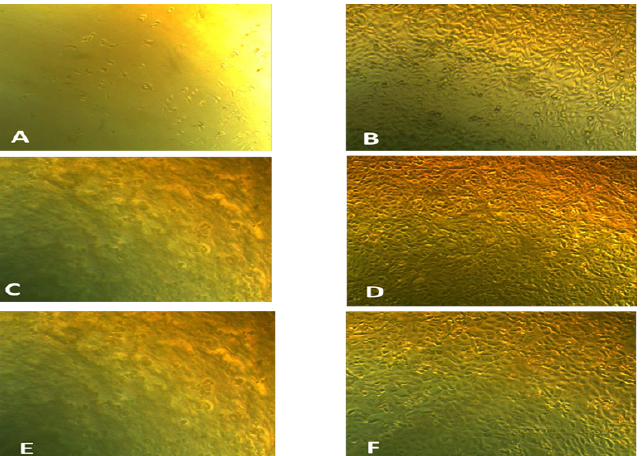
Fig. 10. Photographs illustrating the difference between the tested silver nanoparticles on growth of CaCo-2 tumor cell line (A) compared to control (B); on growth of HepG2 (C) compared to control (D) and on growth of MCV tumor cell line (E) compared to control (F)